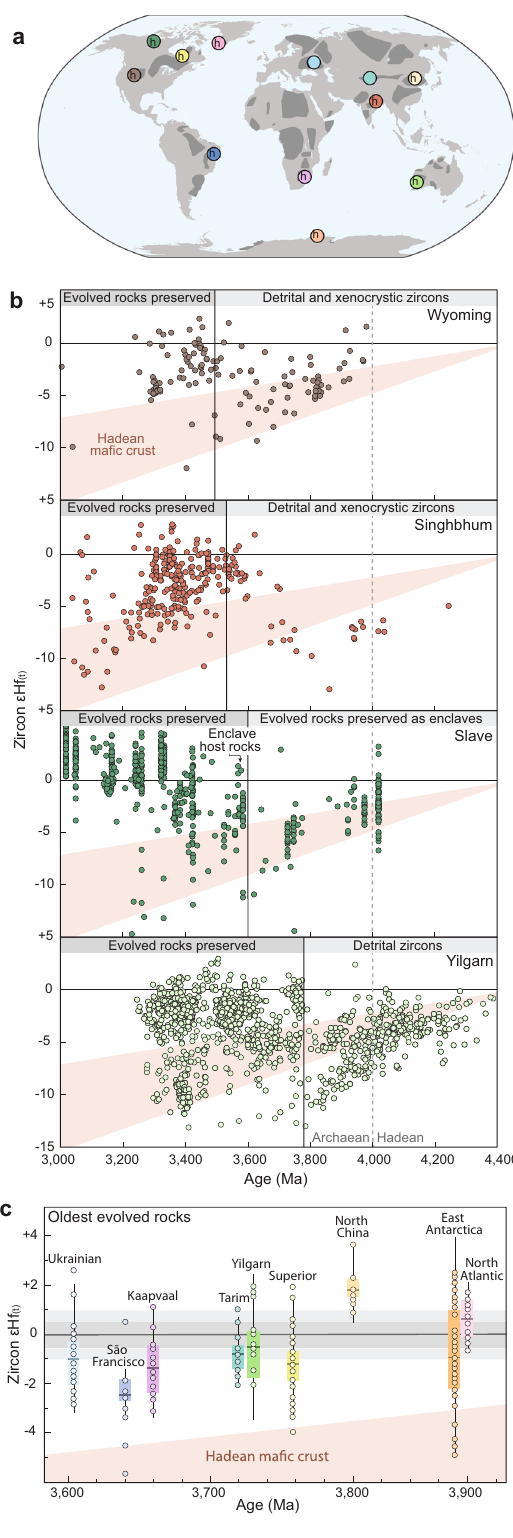
Fig. 3 Zircon Hf isotopic systematics of Earth ’ s oldest evolved rocks. a World map showing Archaean cratons in dark grey (modi fi ed from ref. 23 ). Coloured circles show Eoarchaean cratons with data plotted in panels b and c . Eoarchaean cratons preserving Hadean zircons, radiogenic Pb, or 142 Nd isotopic signatures are labelled ‘ h ’ . b Zircon ε Hf (t) – time plots for Archaean cratons that record a link between a step-shift in Hf isotope evolution and the preservation of evolved rocks. Black vertical line marks the age of the oldest rock dated by U – Pb zircon geochronology. Dashed grey vertical line shows the Hadean – Eoarchaean boundary. The Hf isotopic evolution of the Hadean ma fi c crustal reservoir documented in the Yilgarn Craton is shown in red. c Box plots of zircon ε Hf (t) data from the oldest TTGs in different Eoarchaean cratons. Box limits de fi ne upper and lower quartiles, the thick horizontal line shows the mean, whiskers show 1.5 x interquartile range, points show individual analyses. Horizontal grey bars show chondritic reference values ±0.5 and ±1 ε Hf units. See Supplementary Note 1 for sources and details of compiled